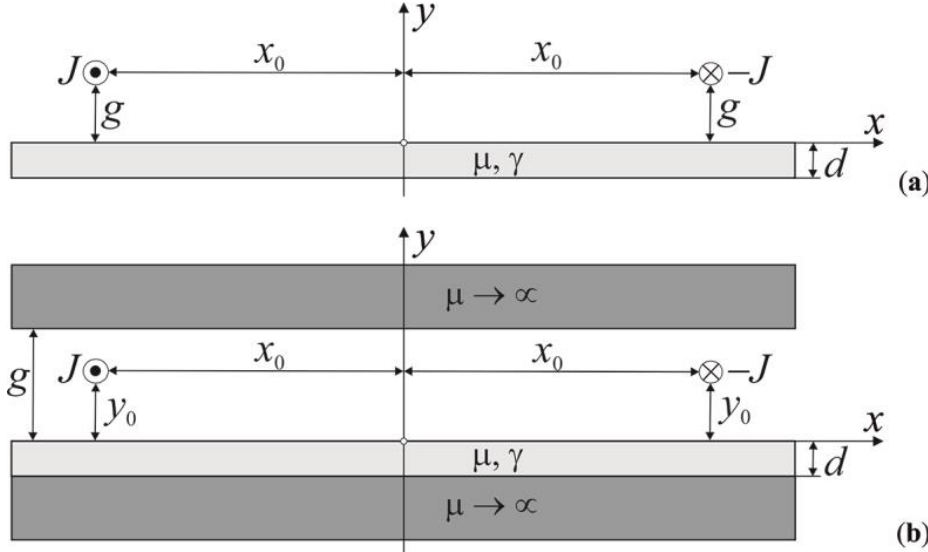
Figure 5. Two filaments 2 x 0 apart, placed at a distance g above the conducting plate of thickness d [61] ( a ). The back iron and primary iron are additionally modeled as two infinite layers with zero conductivity and infinite permeability ( b ).